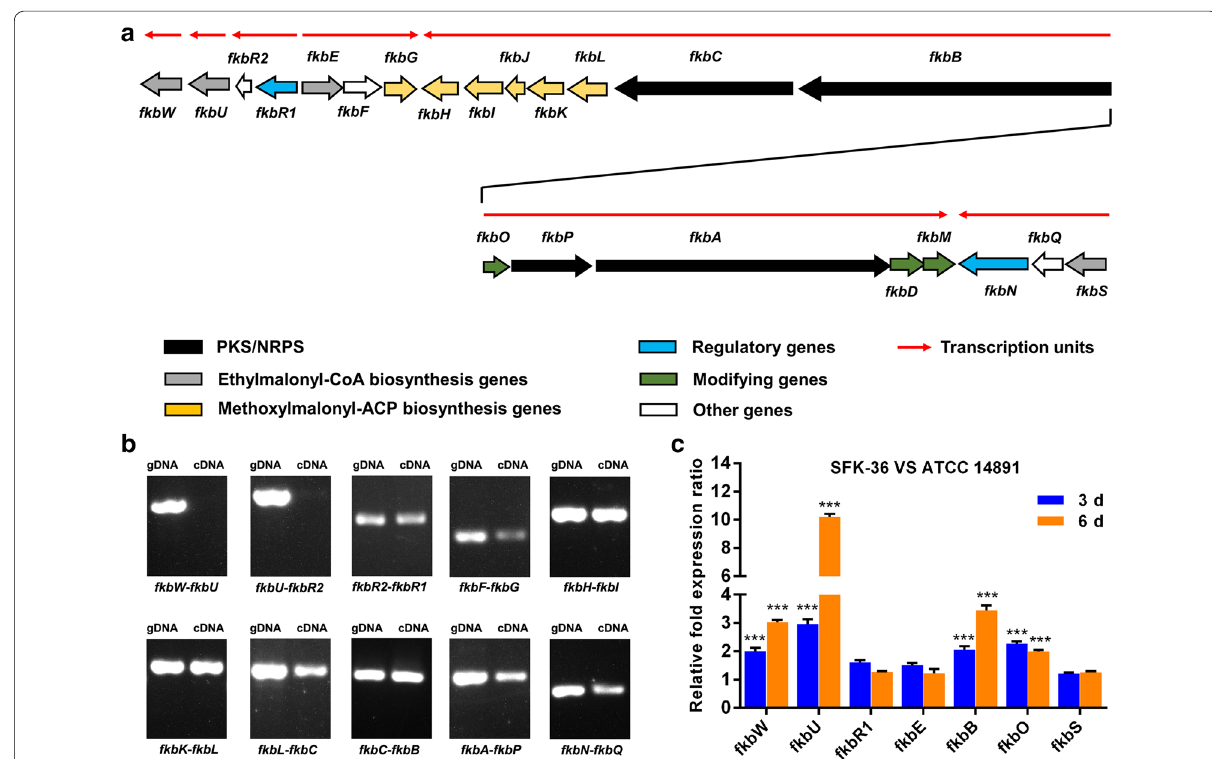
Fig. 2 Transcriptional analysis of ascomycin biosynthetic gene cluster in S. hygroscopicus . a Genetic organization of co-transcription units in ascomycin biosynthetic gene cluster. b Co-transcriptional analysis of the ascomycin biosynthetic gene cluster by RT-PCR. Genomic DNA (gDNA) and cDNA of S. hygroscopicus 14891 strain were used for PCR amplification. c Relative expression levels of ascomycin biosynthetic gene cluster in S. hygroscopicus SFK-36, compared with those in ATCC 14891 strain. Totally, seven genes were selected to indicate the expression level of co-transcription units (***P <